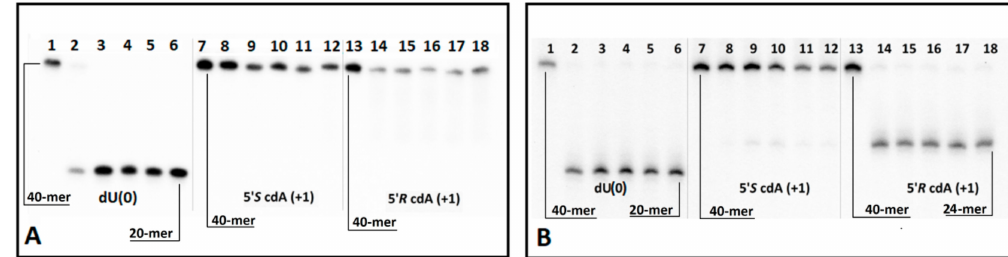
Figure 5. Digestion of oligonucleotides ScdA( + 1) and RcdA( + 1) in double-stranded forms: ( A ) by UDG and hAPE1 and ( B ) by UDG and hAPE1 with subsequent 1M piperidine treatment. Lines 1–6 correspond to ds- Cont.dU(0); lines 7–12 correspond to ds- ScdA( + 1); lines 13–18 correspond to ds- RcdA( + 1). In each case, the following order of reaction times was used: 0, 5, 60, 120, 180, 240 min, starting from the